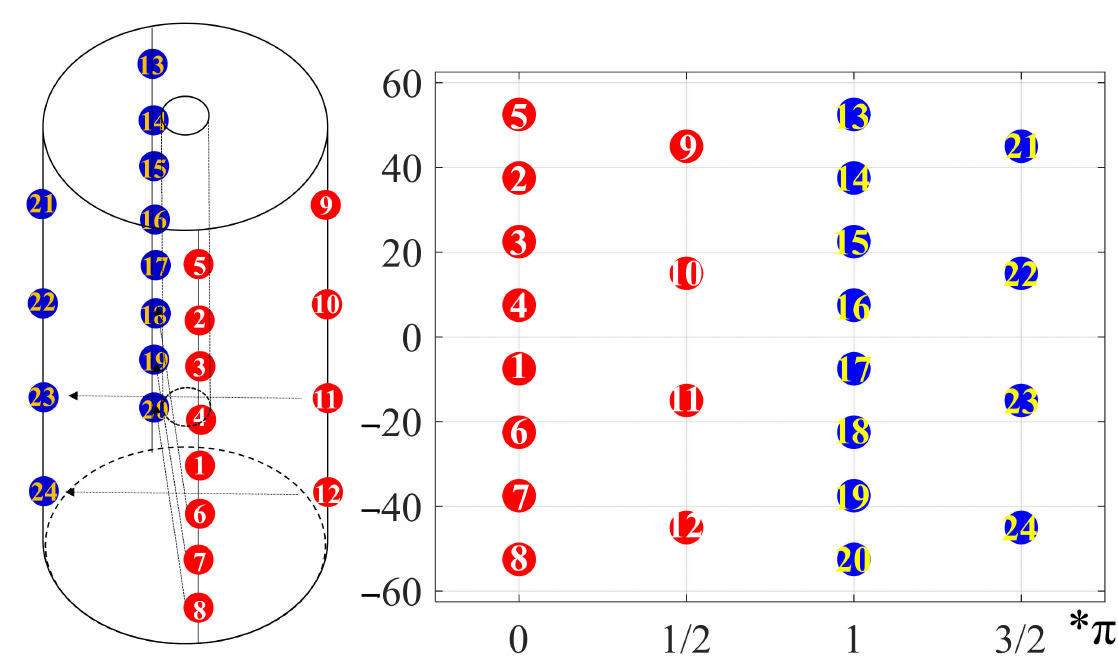
Figure 3. Distribution of piezoelectric transducer sensors mounted on the surface of the test sample. PZT 1–12 (the red dot) indicates ultrasonic wave emission sensors, and PZT 13–24 (the blue dot) served as the receiving probes. An expanded view of the lateral cylinder is showed in the cylindrical coordinate